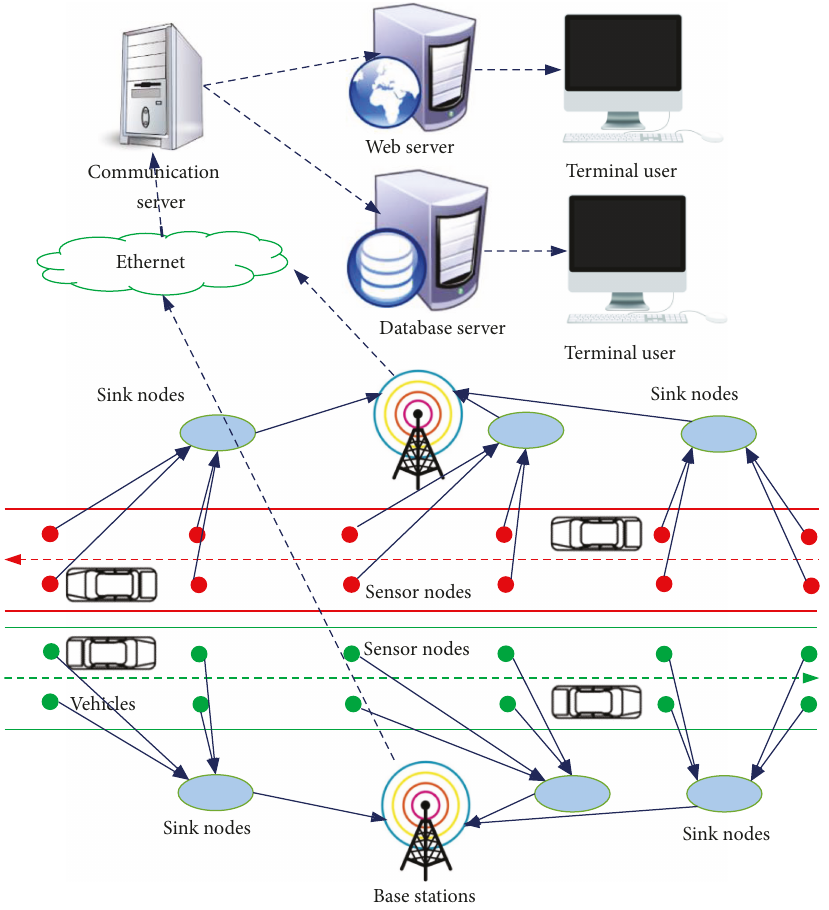
Figure 7: Collection of random tra ffi c fl ow loads using the wireless sensor